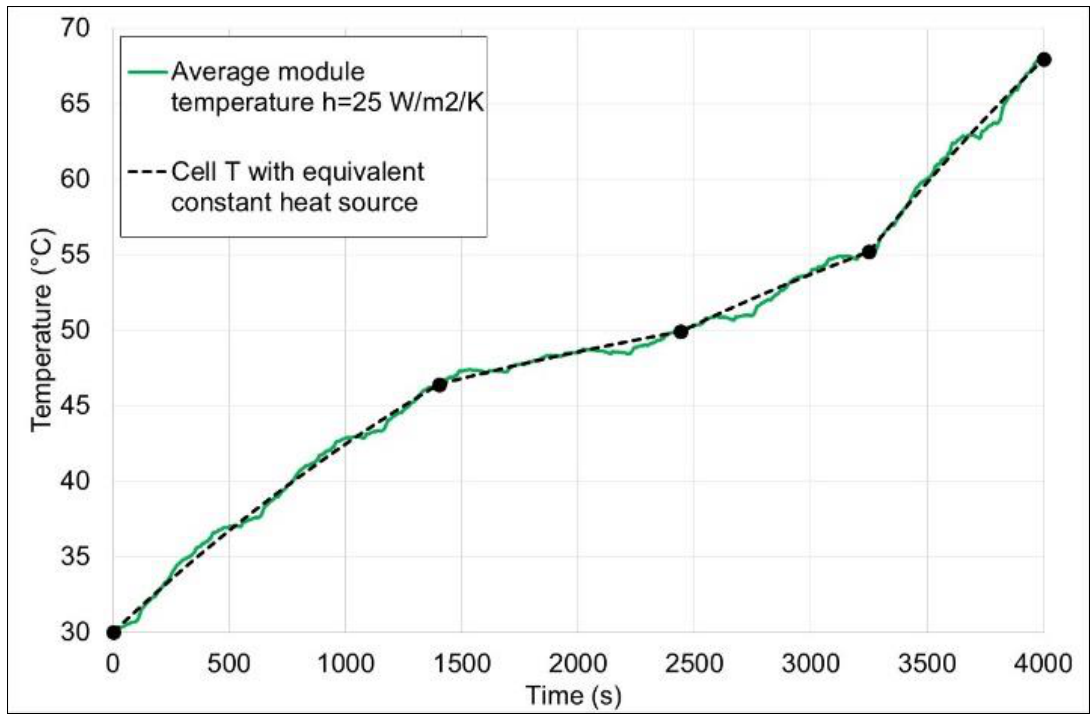
Figure 23. Average cell temperature for repeated highway driving profiles.